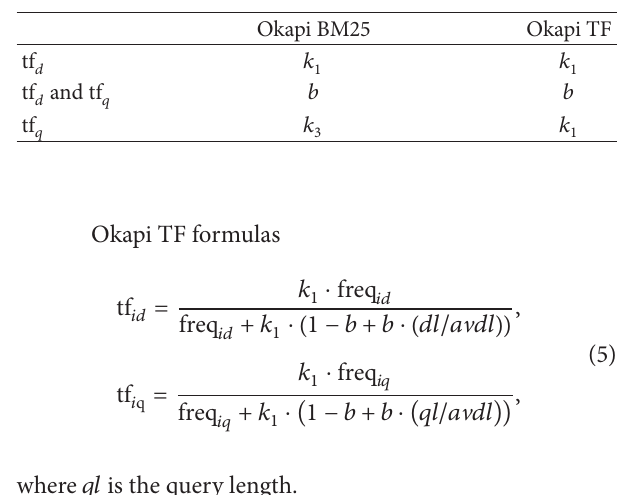
Table 3: Correspondence between parameters of the BM25 weight- ing and Okapi